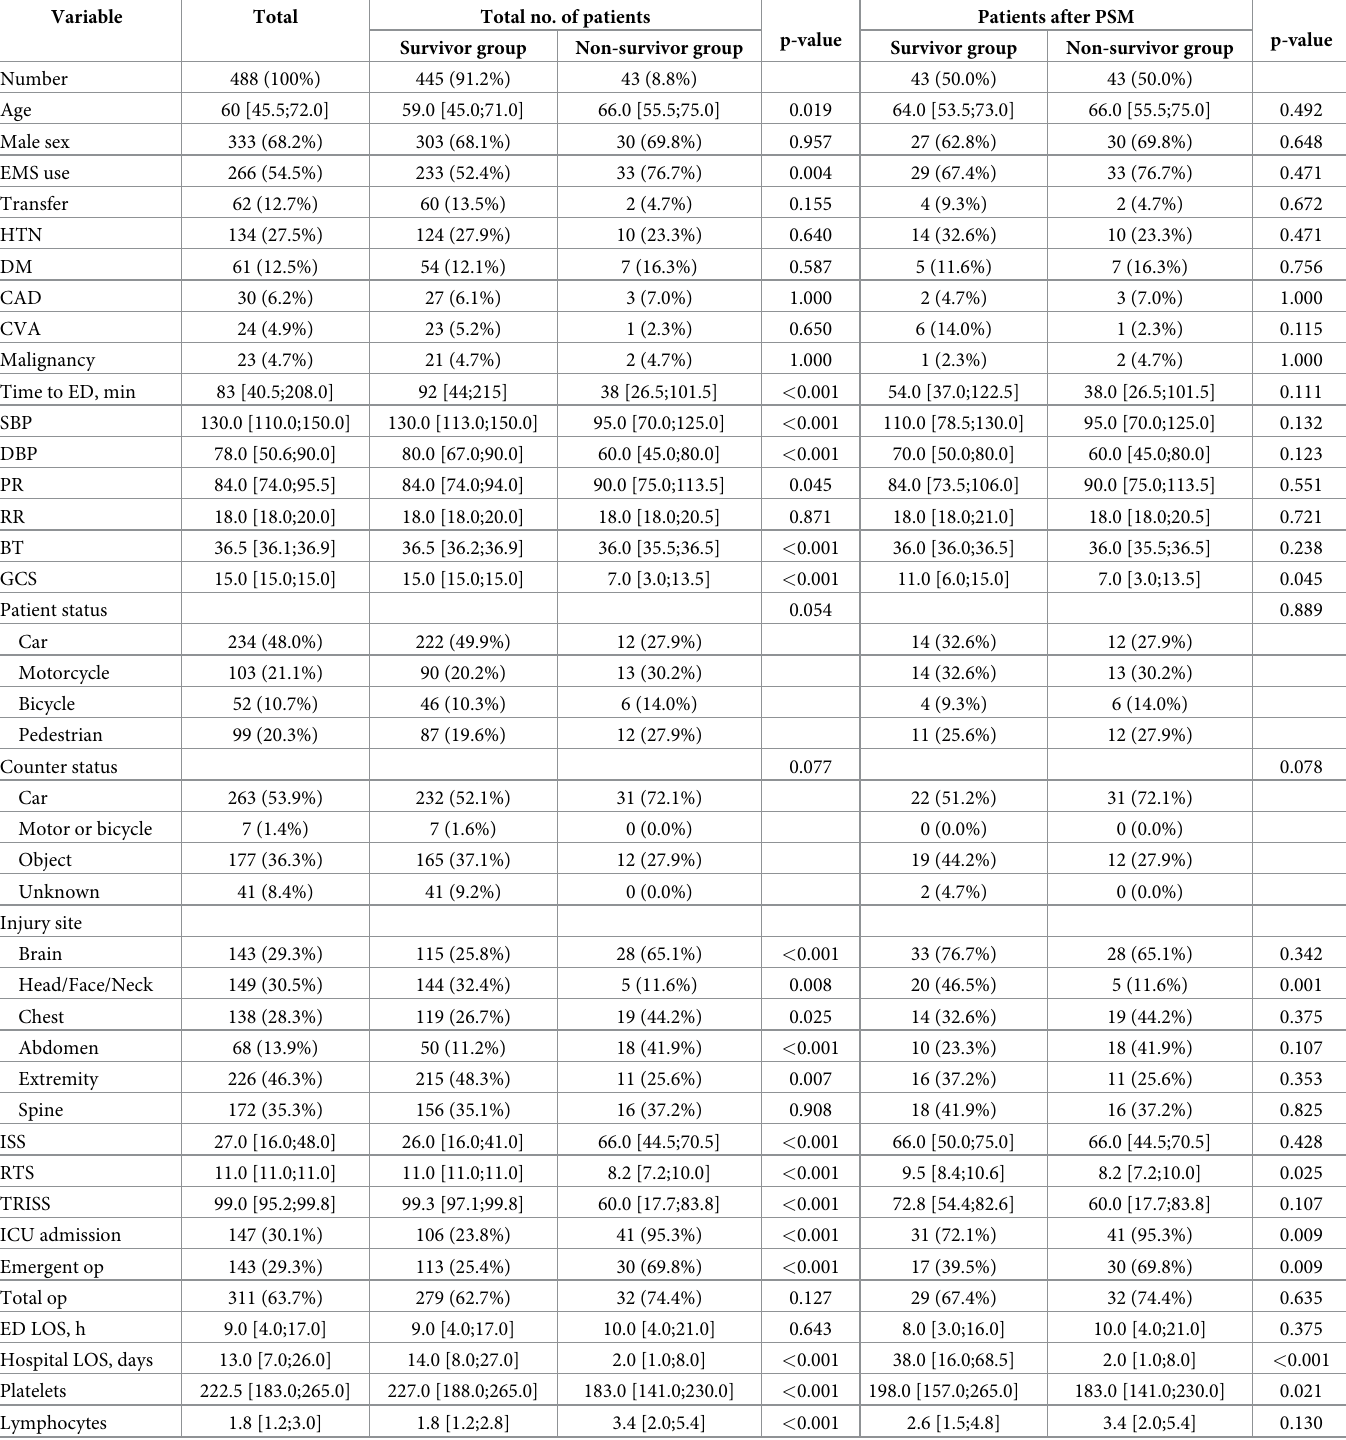
Table 1. Baseline characteristics of the enrolled patients, comparison between survivor and non-survivor groups, and 1:1 propensity score matching (PSM) of